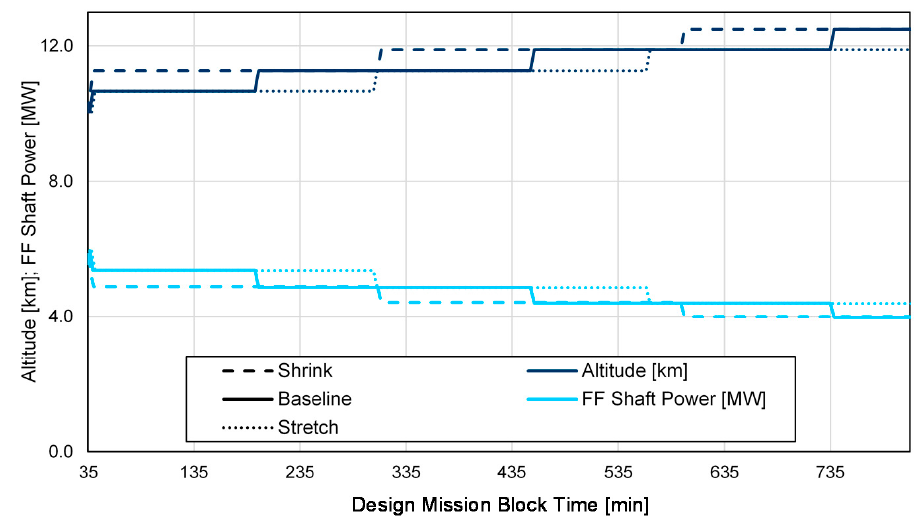
Figure 36. Cruise altitude and FF ideal shaft power profile for the PFC family members at Ma 0.82, ISA+10 K (adapted from [69]).